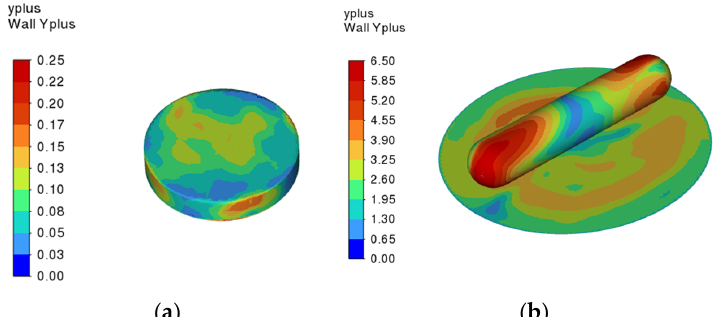
Figure 7. CFD predictions of the wall y + value on ( a ) the surface of the tablet; and ( b ) the surface of the stirrer and the base of the beaker for the stirrer 3 system with a rotation speed of 200 rpm. Figure 8 shows the contours of the turbulent viscosity ratio, which is the ratio of the turbulent viscosity to the laminar viscosity, in the fluid. The ratio is highest with stirrer 1, followed by stirrer 3, then stirrer 2. With stirrer 1, the highest values are observed above the stirrer. With stirrer 3, the highest values are near the tips of the stirrer. However, in all cases the region around the tablet is largely unaffected by turbulence.